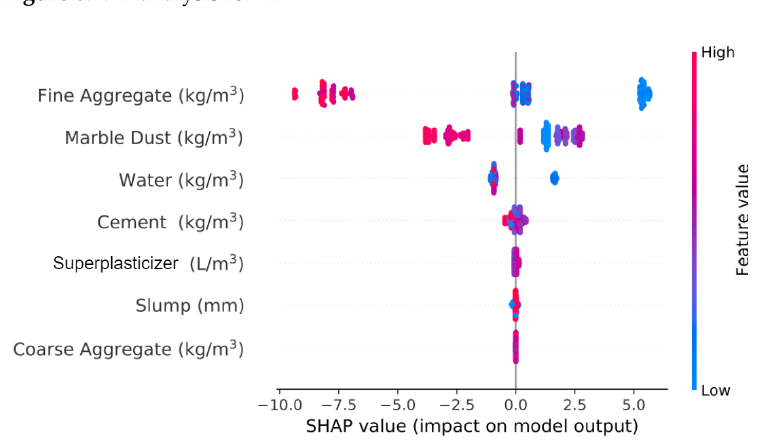
Figure 6. VIF analysis for RF.